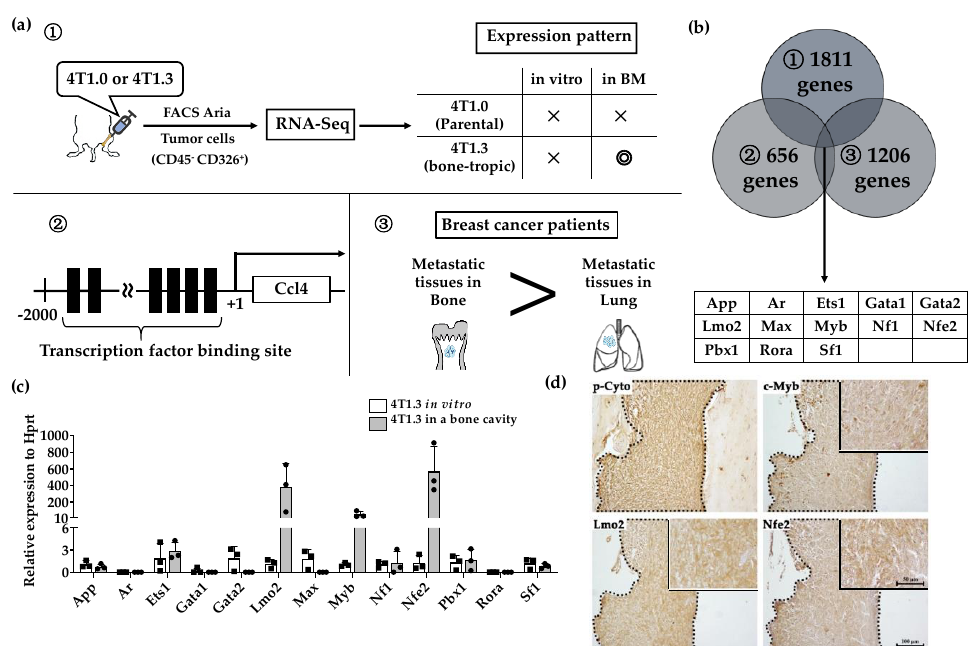
Figure 2. ( a ) Schematic representation of the procedures to identify candidate Transcription factors. ( b ) A total of 13 transcription factors fulfilled 3 conditions described in Figure 2a. ( c ) mRNA expression level of 13 extracted transcription factors in 4T1.3 cells, which grew in a bone marrow cavity or were cultured in vitro. Total RNAs were extracted from 4T1.3 cells, either isolated from the bone marrow cavity at day 7 after intraosseous injection, or cultured in vitro. The expression levels of 13 transcription factors were determined by qRT-PCR. The mean and SD values were calculated from 3 animals or 3 independently in vitro cultured cells. ( d ) Immunohistochemical analysis of 4T1.3 cells in a bone cavity. Tibiae were obtained from mice 7 days after intraosseous injection of 4T1.3 cells and were subjected to IHC staining by using anti-pan cytokeratin, anti-LMO2, anti-MYB, or anti-NFE2 antibodies. The tumor foci were indicated as the positive areas of pan cytokeratin, which were demarcated by dot lines. Representative images from 5 independent mice are shown here. Insets indicate enlarged area of tumor foci. Scar bars, 100 μm in main images, 50 μm in insets.